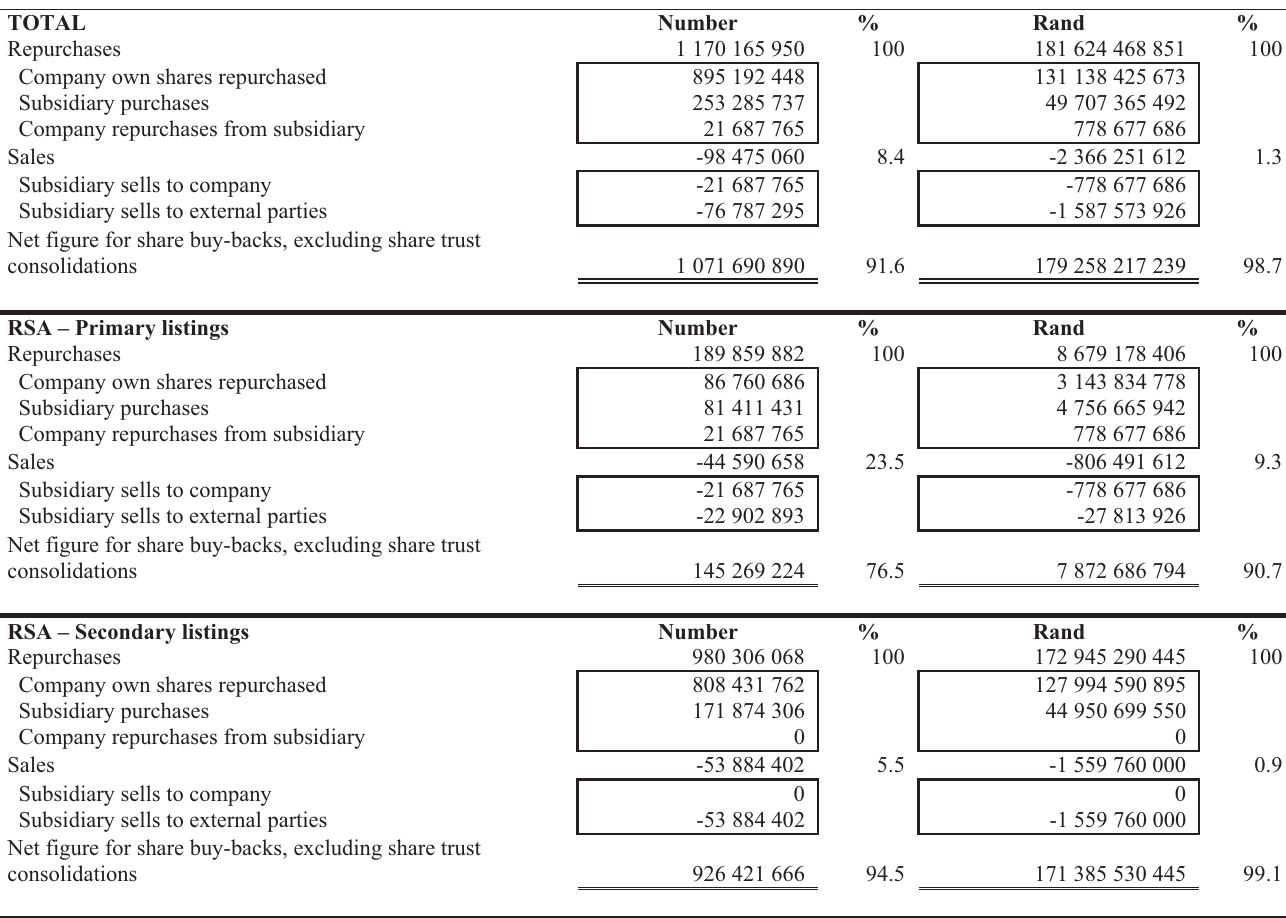
Table 6: Share buy backs: Purchases and sales